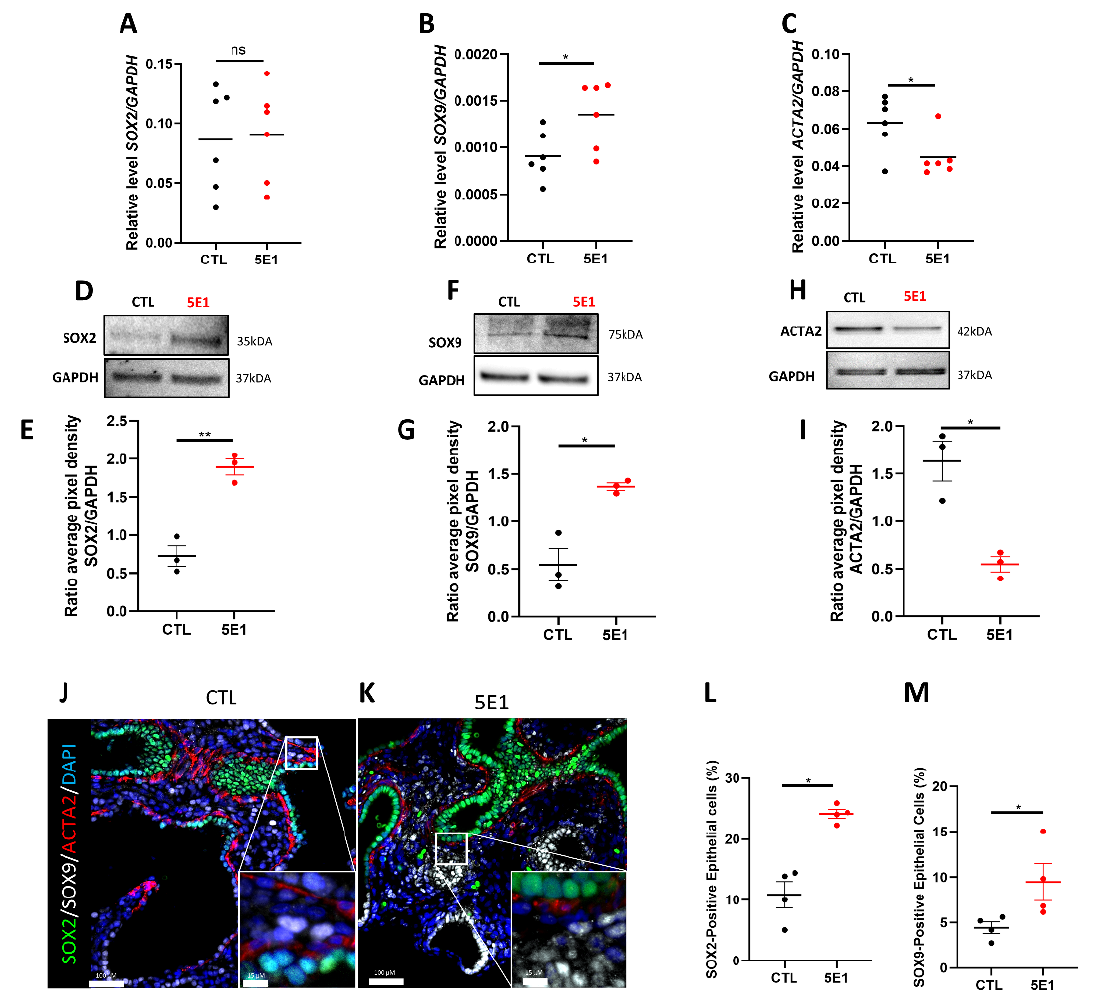
Figure 4. Compartmental cell identity is altered upon Hedgehog pathway inhibition. RT-qPCR for SOX2 ( A ), SOX9 ( B ), and ACTA2 ( C ) in fetal lung explants treated with 5E1 compared to control. Results are shown as mean ± SEM, * p < 0.05, n = 6 for each group. ( D – H ) Western blot analysis of protein expression of SOX2 ( D , E ), SOX9 ( F , G ), and ACTA2 ( H , I ) in 5E1 treated explants compared to control ( n = 3 for each condition). Western blot densitometry ratios are shown in ( E , G , I ) ( n = 3 for each condition). Results are shown as mean ± SEM. IF staining of fetal lung explants treated ( K ) or not ( J ) with 5E1 for SOX2 (green), SOX9 (white), and ACTA2 (red). Quantification of the number of epithelial positive SOX2 cells ( L ) and SOX9 ( M ) ( n = 4 for each group). * p < 0.05, ** p < 0.01.